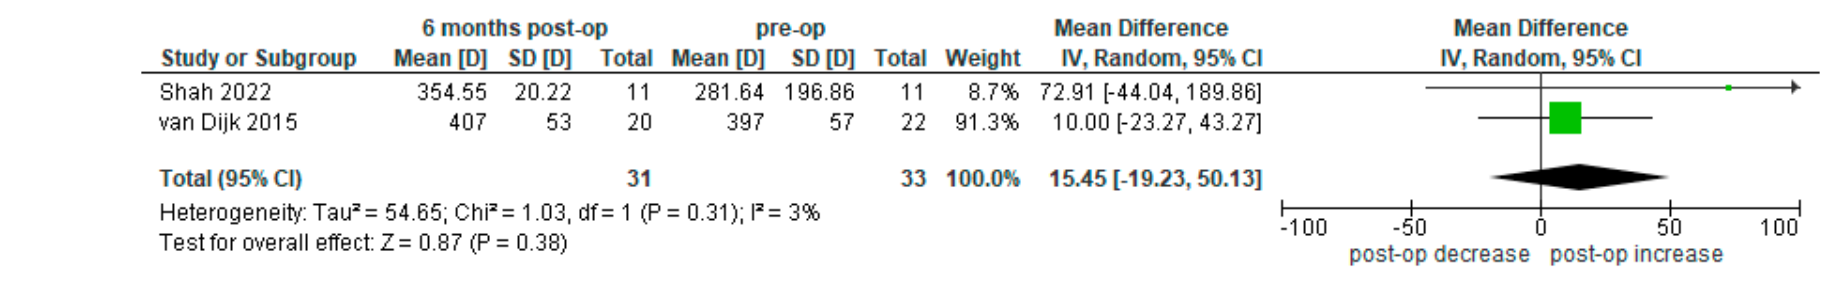
Figure A9. Di ff erence in pachymetry thinnest point in 1 study [31]. Figure A9. Difference in pachymetry thinnest point in 1 study [31].